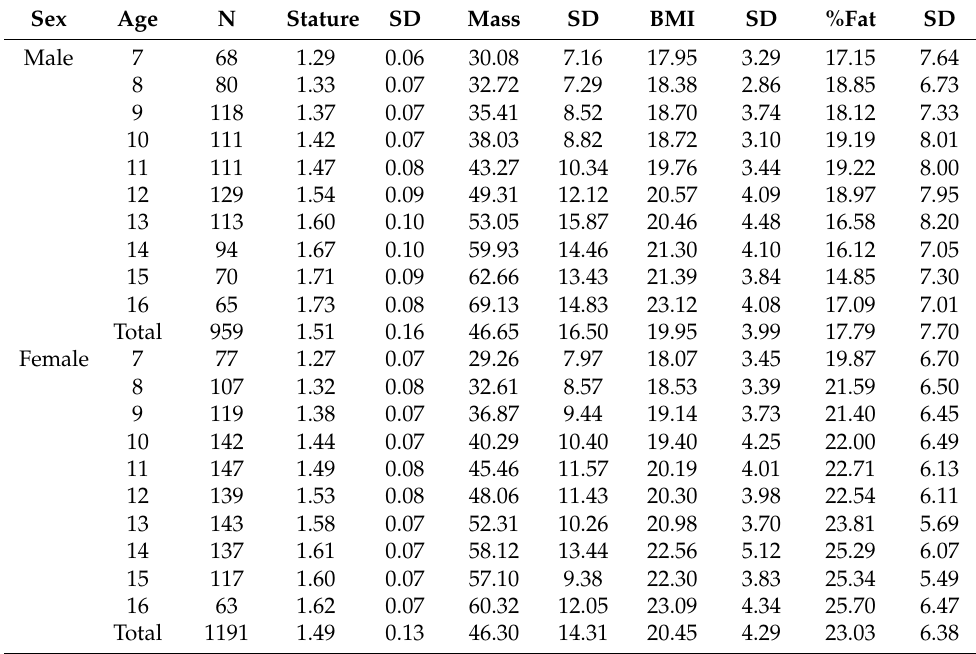
Table 1. Anthropometric descriptive data for the